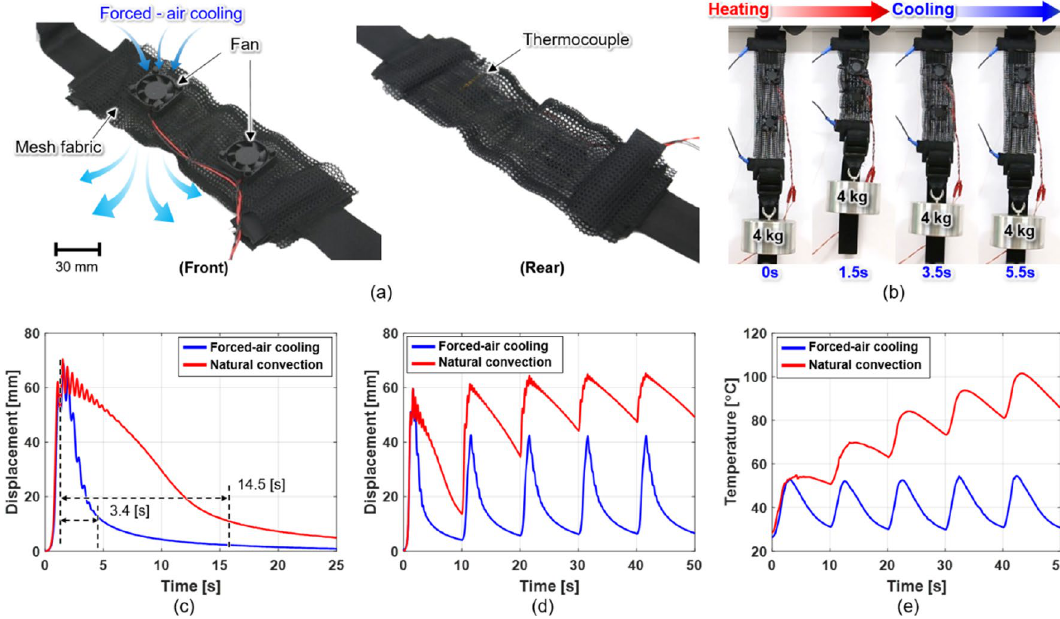
Figure 5. Performance evaluation of fabric muscle under FAC. ( a ) Front view of fabric muscle attached with two small fans for forced air cooling (left). A thermocouple is attached inside the fabric muscle to measure the actuation temperature of the fabric muscle (right). ( b ) The upper end of the fabric muscle was fixed to a frame, and a 4 kg mass was hung at the lower end. Sequence of contraction and relaxation by 19 A and 1.5 s Joule heating and FAC. ( c ) Comparison of relaxation rates of fabric muscle measured during Joule heating and cooling under different cooling conditions (see Video S1). Comparison of change in ( d ) displacement and ( e ) temperature when performing contraction-relaxation at actuating frequency of 10 s under NCC and FAC.